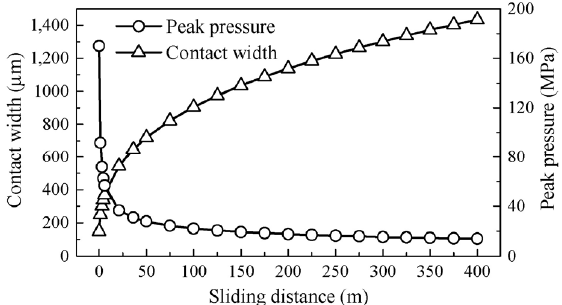
Fig. 8 Evolutions of contact width and peak pressure with increasing sliding distance.